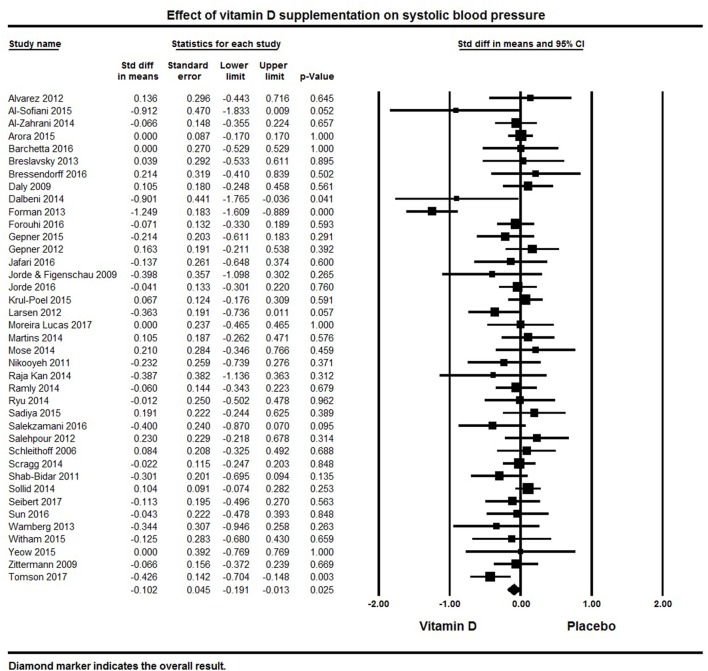
Forest plot detailing standardized mean difference for the impact of vitamin D on systolic blood pressure.